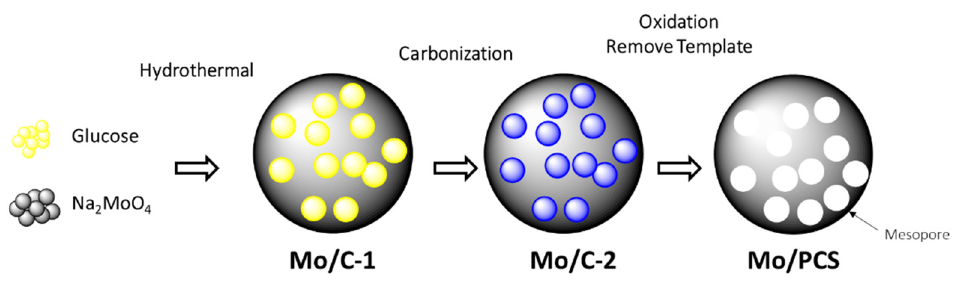
Figure 9. Schematic representation of the fabrication of the porous carbon spheres (PCS). Hydrothermal carbonization is a strong, cost-effective, and ecologically acceptable method for converting organic molecules into usable carbon materials. Under mild hy- drothermal conditions, a variety of organic compounds such as glucose, sucrose, starch, fructose, alginic acid, among others, can be transformed into carbonaceous spheres [122]. Pan et al. obtained a porous carbon from asphalt, whose properties highlight its high specific capacity of 277 F g − 1 at a current density of 0.05 A g − 1 . According to the authors, the ultrathin and porous structure reduces resistance by minimizing the diffusion distance of electrolyte ions and aids the plentiful porosity channels as active locations for ion transport and storage [123]. These precedents utilized organic wastes to make porous carbon with good capaci- tance performance, opening a novel way to transform organic wastes into supercapacitor material and lowering carbon material costs. The specific capacitance of these carbon ma- terials, on the other hand, has yet to increase their scalability. Therefore, it is important to prepare carbon materials with high specific capacity from low-cost biomass feedstocks. In this sense, Kong et al. employed maize starch as a carbon precursor, which they synthesized by dissolving corn starch in KOH solution and fabricating a starch-based gel after the water was removed. Finally, 3D-reticular porous carbon (3D-RPC) was created by carbonizing a starch gel and activating KOH in situ (a process like those described by Hao et al.). The advantages of 3D-RPC include a wide surface area, high porosity and an optimum pore size distribution. The macropores formed with this new material (3D-RPC) are primarily from the intermediate space between the three-dimensional starch gel net- works, whereas the KOH activation process produced mesopores and micropores. The material’s porosity displayed exceptional supercapacitive performance with a 372 F g − 1 specific capacitance (0.5 A g − 1 ). The electrochemical performance of 3D-RPC outperforms that of most previously characterized carbon materials, opening a new path for large-scale production of a low-cost, high-purity porous carbon for supercapacitors [124].